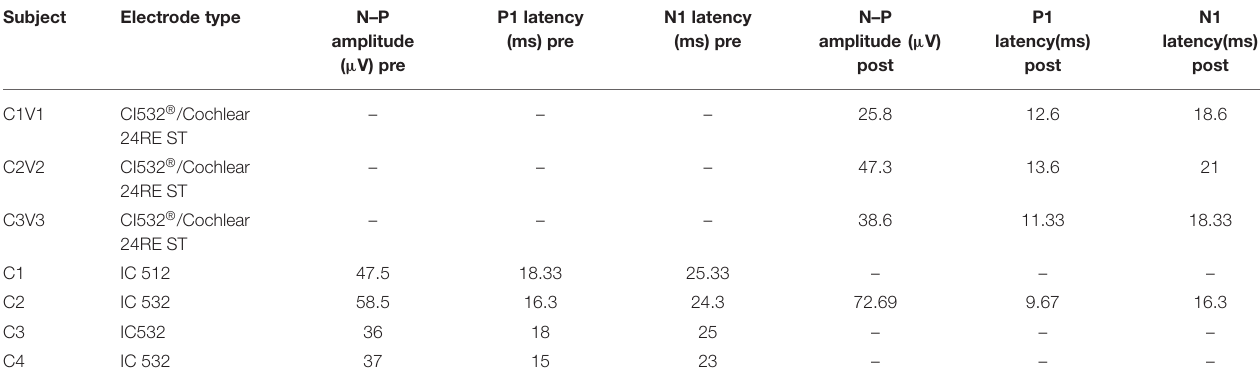
TABLE 2 | Characteristic of cervical VEMPs pre-operative and evoked by electrical stimulation after surgery in both